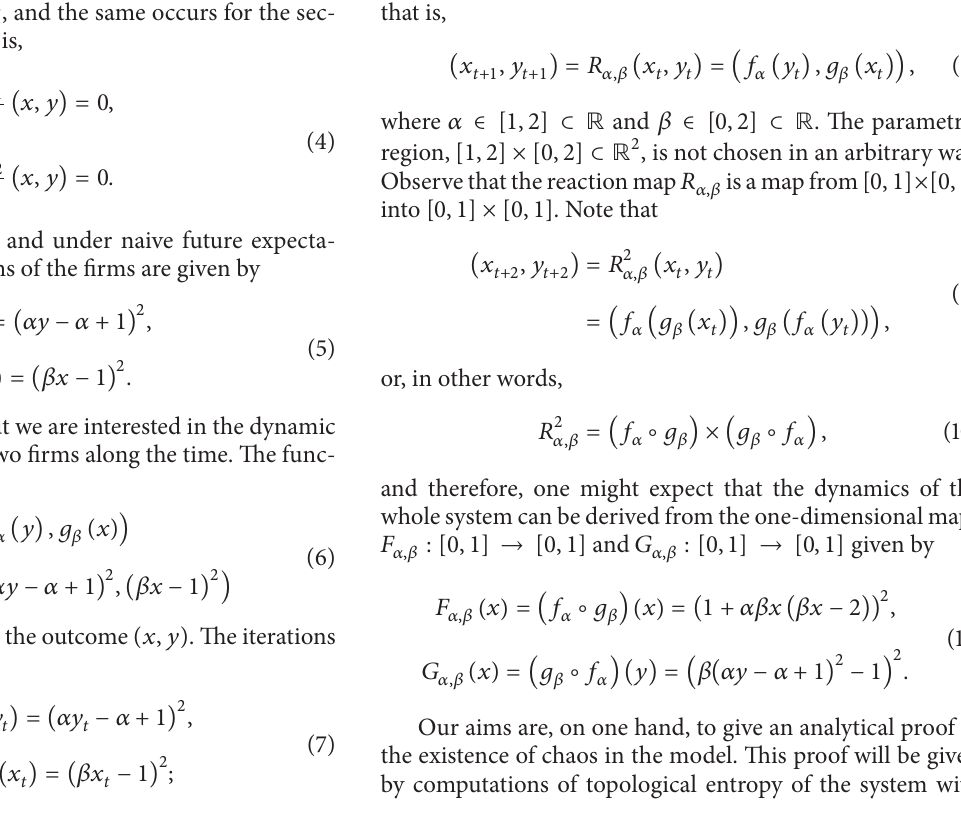
the profit with respect to 𝑥 , and the same occurs for the sec- ond firm respect to 𝑦 , that